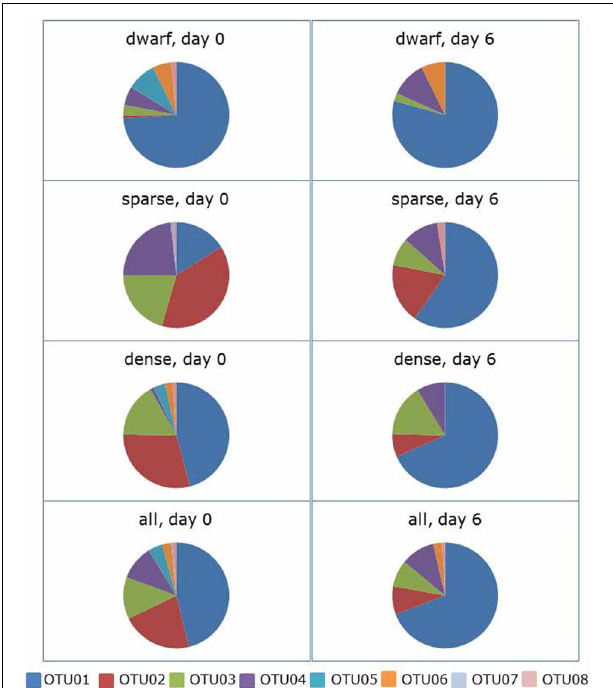
FIGURE 3 | Effect of 6 days of ammonium enrichment on the sequence distribution of ammonia-oxidizing betaproteobacteria in shaken soil slurries. Sequences originated from different vegetation cover types of Avicennia germinans forests sampled in 2010. Operational Taxonomic Units (OTUs) are based on the partial 16S rRNA gene